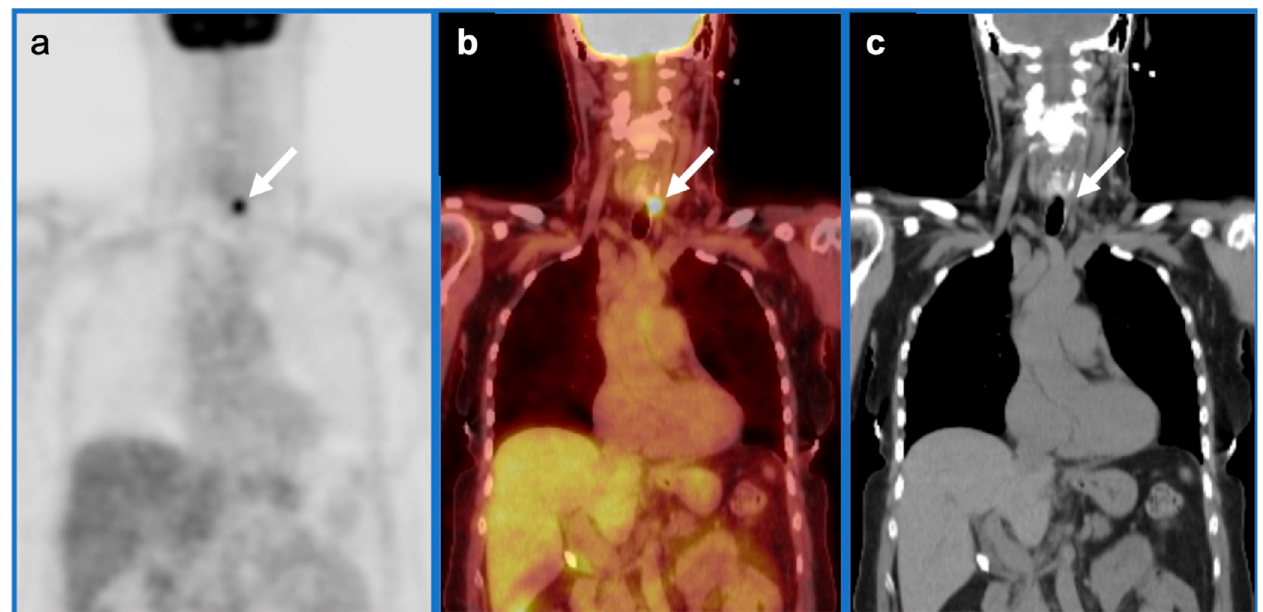
Figure 31. Recurrent differentiated thyroid cancer. Coronal ( a ) FDG PET, ( b ) fused FDG PET ‐ CT, and ( c ) CT demonstrate a small hypermetabolic site of recurrent thyroid cancer along the left aspect of the trachea (white arrows) in a patient with a rising thyroglobulin following surgery and 131 I NaI ablation for well ‐ differentiated papillary thyroid cancer.